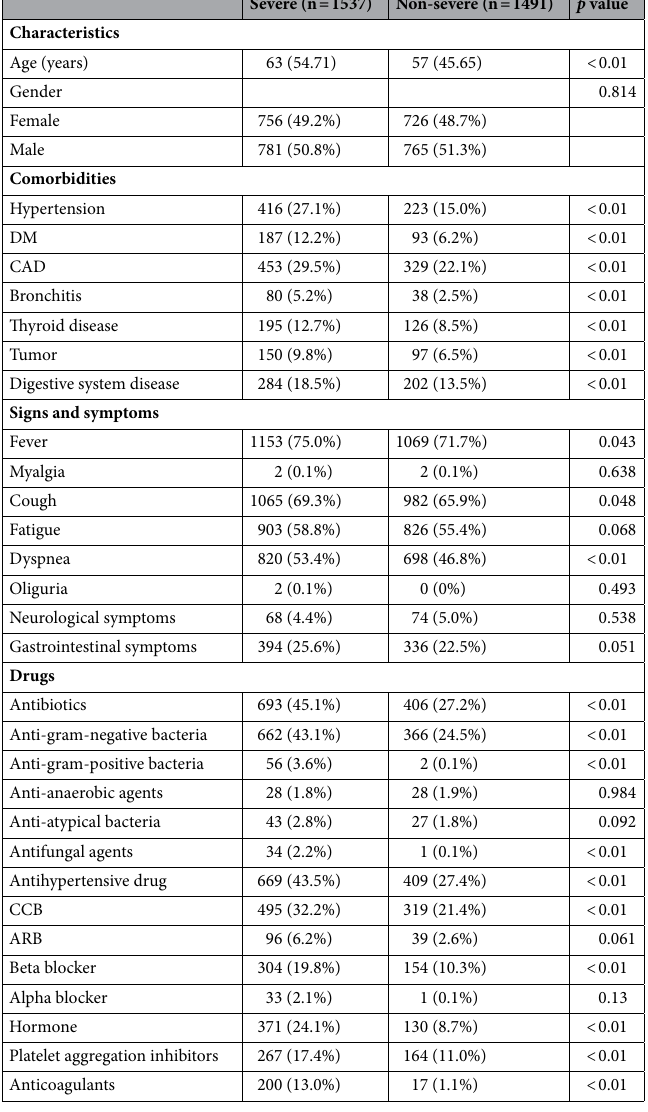
Table 1. Baseline characteristics for COVID-19 based on